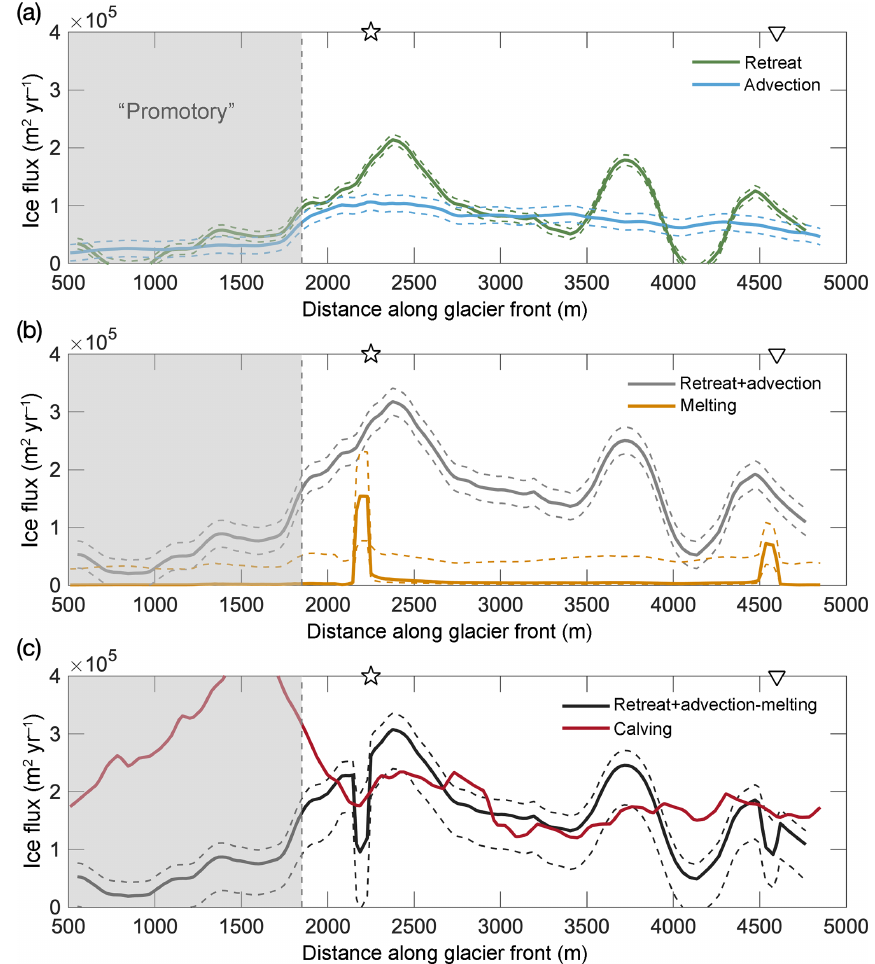
Figure 7. Flux balance along the glacier front. Dashed lines indicate uncertainties as discussed in the text. (a) The green line represents the July 2013 retreat rate and the blue line the advective ice flux. (b) Sum of retreat and advection (gray) and melt flux (orange). (c) Approximate closure of the volume flux budget along the glacier front. The black line shows the residual of advection plus retreat minus melting, while the red line shows the observational calving estimate as in (b) . Note that the calving flux has been scaled to approximately close the budget for the main part of the